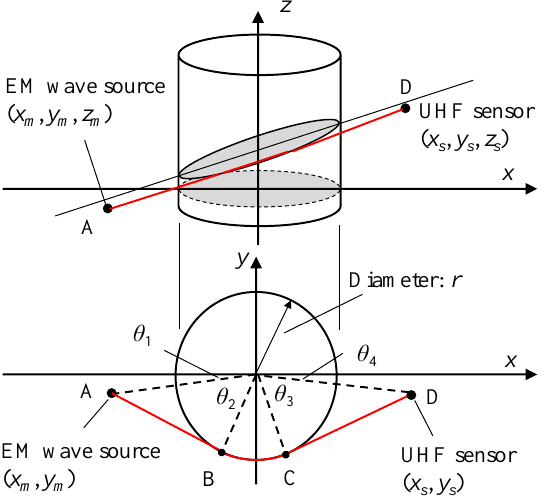
Figure 11. Propagation path of the EM waves around a cylindrical obstacle and its 2-D projection.